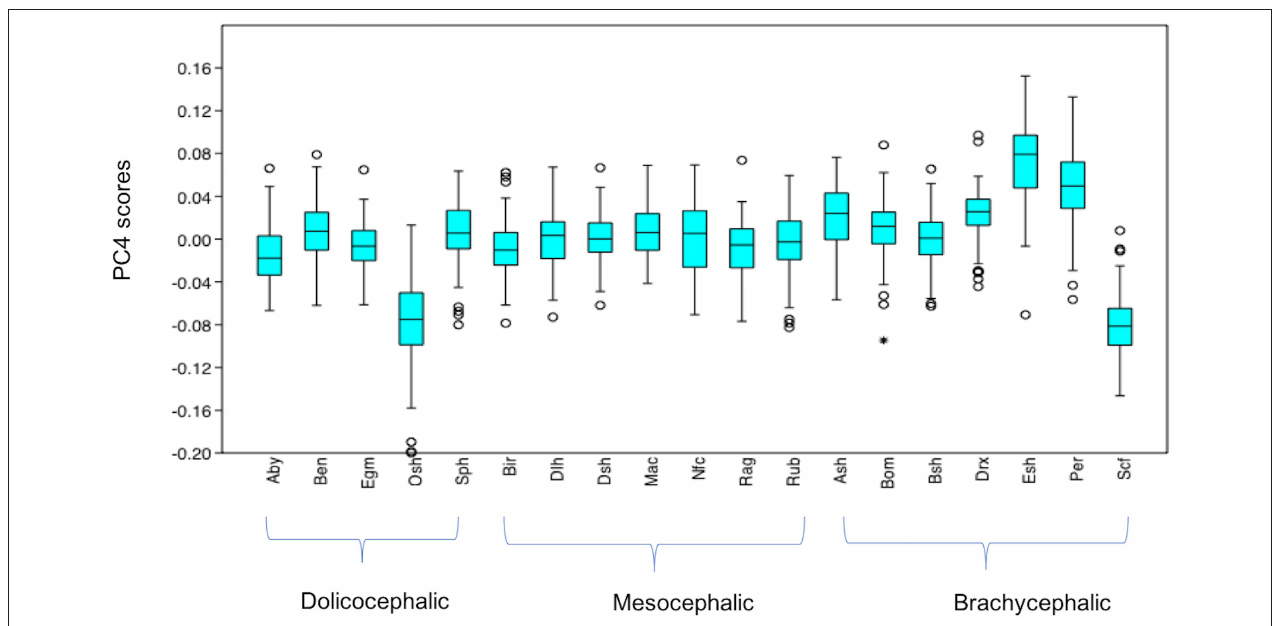
FIGURE 8 | Boxplot with minimum, first quartile, median, third quartile, maximum values and outliers (* denoting more extreme outliers) for PC4 scores for each breed, n = 1,888. Abbreviations for breeds within each cephalic type as follows. Dolichocephalic: Aby, Abyssinian; Ben, Bengal; Egm, Egyptian Mau; Osh, Oriental Shorthair; Sph, Sphynx. Mesocephalic: Bir, Birman; Dlh, Domestic Longhair; Dsh, Domestic shorthair; Mac, Main Coon; Nfc, Norwegian Forest cat; Ragdoll, Russian Blue. Brachycephalic: Ash, American Short hair; Bom, Bombay; Drx, Devon Rex; Esh, Exotic Short hair; Per, Persian; Scf, Scottish fold. For full results of Mann Whitney U -tests see Supplementary Data 5 . For shape changes associated with higher PC4 scores, see Figure 1 .